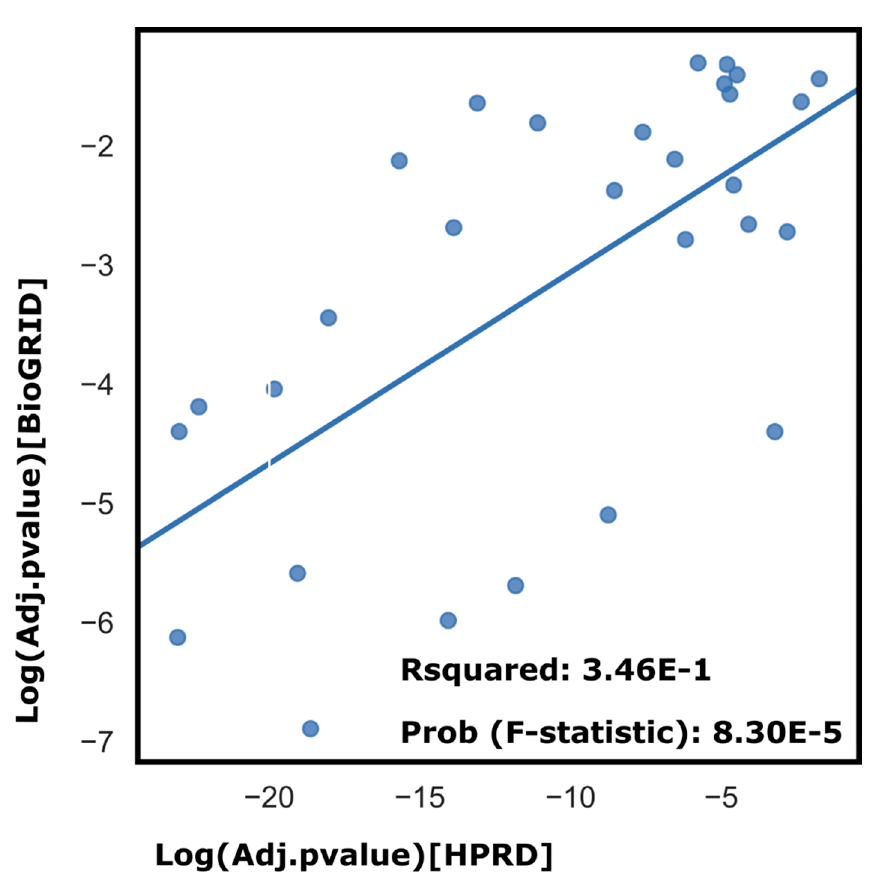
Figure 5. Correlation of pathways as highlighted by HPRD vs. BioGRID. Although the comparison here is for a different number of significant genes for the two datasets (602 for HPRD, 288 for BioGRID), resulting in different orders of magnitudes for the associated p values, the strength of the correlation is high.